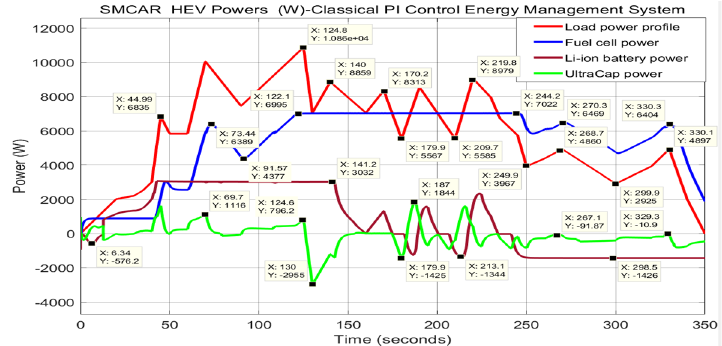
Figure A3. SMCAR HEV Powers—Classical PI Control EMS.